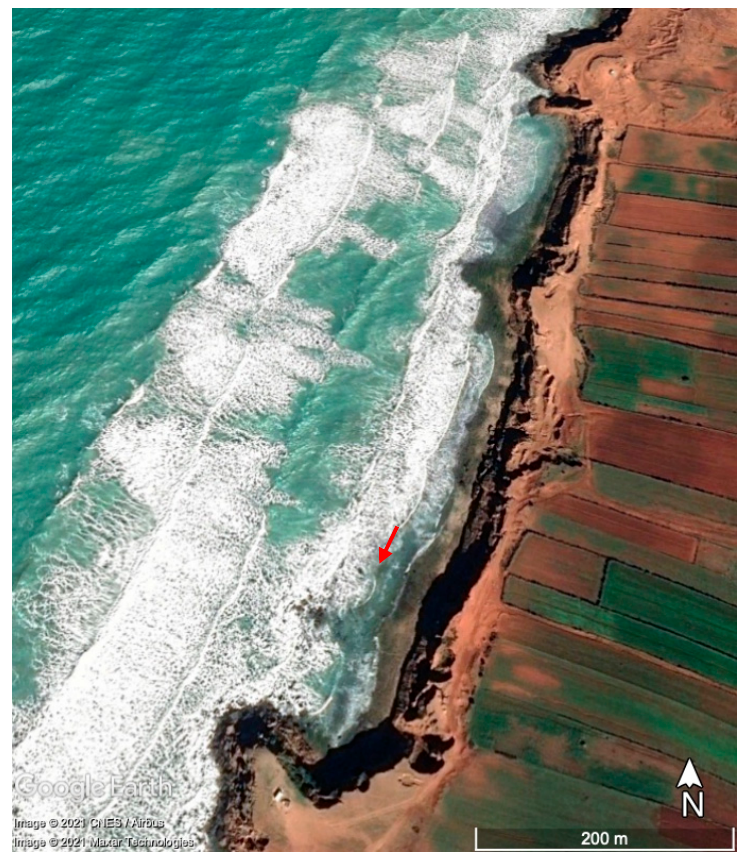
Figure 14. Satellite image (Google Earth) of Laghdira on 16 February 2016 showing northwesterly storm waves with a significant wave height of 4.5 m (almost the same storm conditions as in December 2019). Wave diffraction and energy damping by the cluster of imbricated boulders (red arrow) can be clearly seen.